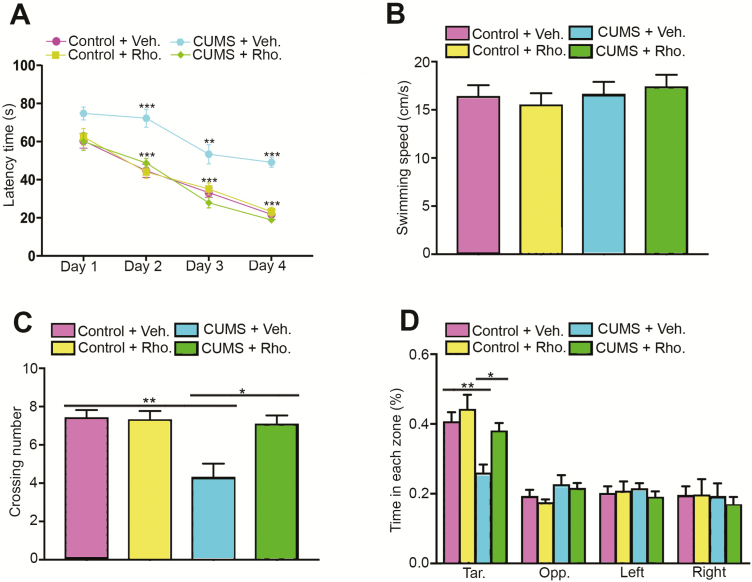
Chronic stress-impaired spatial learning was reversed by rhodomyrtone treatment. Spatial learning was assessed by the Morris water maze (MWM). (A) Escape latency in all groups was improved with training. Rhodomyrtone treatment significantly improved escape latency in the chronic unpredictable mild stress (CUMS) group but had no obvious effects on the control group. (B) The swimming speed in the probe test of each group is indicated. No significant difference was observed. (C) The number of platform crossings in each group is shown. Rhodomyrtone rescued decrease of platform crossing number in CUMS group mice during the probe test. (D) Time spent in each zone. Rhodomyrtone administration increased target zone time in CUMS mice. n=9 for all groups; data are presented as mean±SEM; *P<.05; **P<.01; ***P<.001.